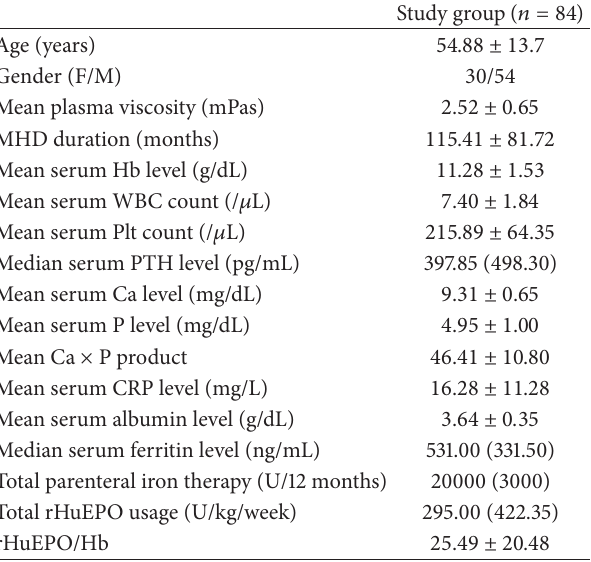
Table 1: Demographic and biochemical characteristics of the whole study group.